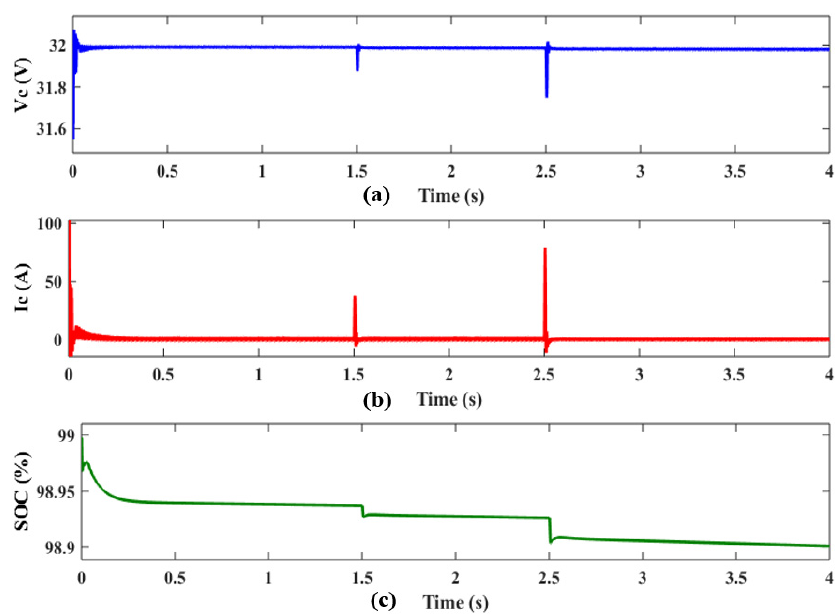
Figure 14. ( a ) Battery voltage ( b ) Battery current ( c ) SOC of battery.